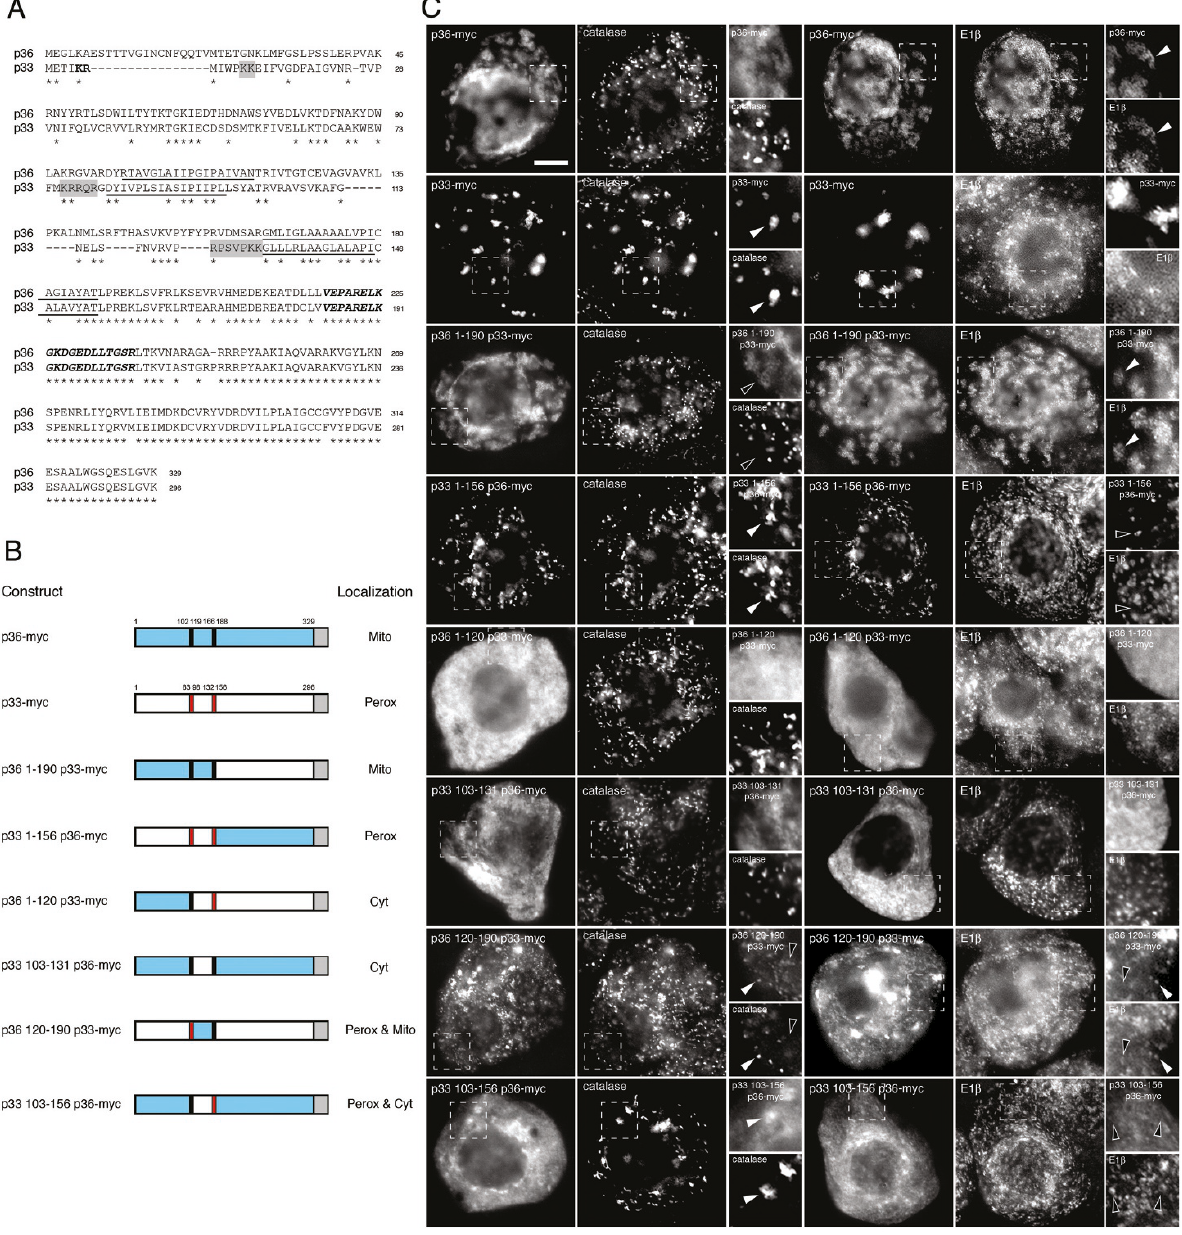
Localization of p36-p33 hybrid proteins in BY-2 cells . (A) Alignment of the deduced amino acid sequences of CIRV p36 and TBSV p33. Sequences were obtained from GenBank and aligned using the ClustalW http://npsa-pbil.ibcp.fr/cgi-bin/npsa_automat.pl?page=npsa_clustalw.html. Identical amino acids in each protein are indicated with asterisks and putative TMDs (underlined) were determined using TMHMM (version 2.0) and visual inspection. Clusters of amino acids in TBSV p33 that were reported previously [ 25 ] to constitute the peroxisomal (i.e., -K 11 K 12 -, K 76 RRQR 80 - and -R 124 PSVPKK 130 -) or pER (i.e., -K 5 R 6 -) targeting signals are shaded grey or bolded, respectively. Conserved residues in p33 (residues 184–203) and p36 (residues 218–237) that are immunorecognized by a polyclonal antibody raised against this (synthetic) peptide sequence [ 25 ] are italized and bolded. (B) Schematic illustra- tions of C-terminal myc-tagged p36 (p36-myc), p33 (p33-myc) and various p36-p33 hybrid proteins and their corresponding subcellular localizations in transformed (via biolistic bombardment) tobacco BY-2 cells. The numbers in the name of each hybrid construct denote the specific amino acid residues from p36 or p33 that were fused to (trunctated) p33-myc or p36-myc, respectively. Portions of the p36 ORF are colored blue or black, the latter denoting the two putative TMDs in p36 and the numbers shown above p36-myc indicating their relative amino acid positions. Similarly, portions of the p33 ORF are colored white and red, the latter denoting the two putative TMDs in p33 and the numbers shown above p33-myc indicating their relative amino acid posi- tions. The grey colored box for each construct denotes the C-terminal appended myc epitope. Cyt, cytosol; Mito, mitochondria; Perox, peroxisome. (C) Representative (immuno)epifluorescence micrographs illustrating the localizations of the various constructs shown in (B). Each micrograph is labelled at the top left with the name of either the transiently-expressed protein, the endogenous mitochondrial matrix marker protein E1 β , or the endogenous per- oxisomal matrix marker protein catalase. Hatched boxes represent the portion of the cells shown at higher magnification in the panels to the right. Solid arrowheads indicate obvious colocalizations; open arrowheads indicate obvious non-colocalizations. Bar = 10 μ